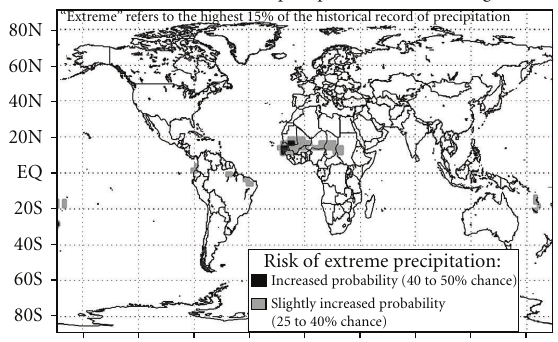
Figure 3: World areas likely to be at risk of “extreme” precipitation in the JJA season (source: